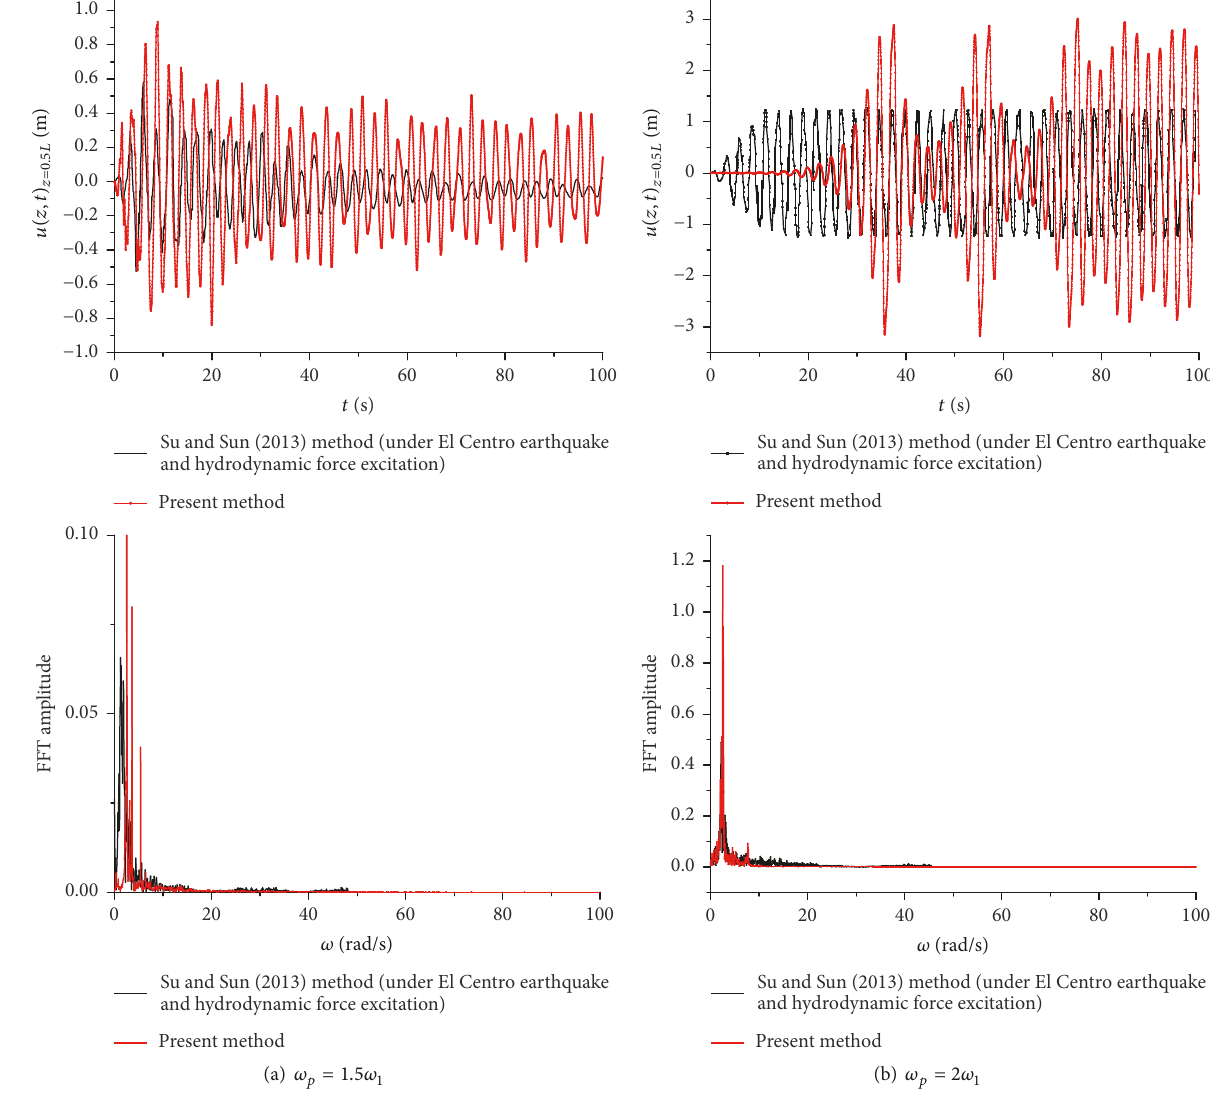
Figure 4: Mid-span displacement of the cable subjected to El Centro